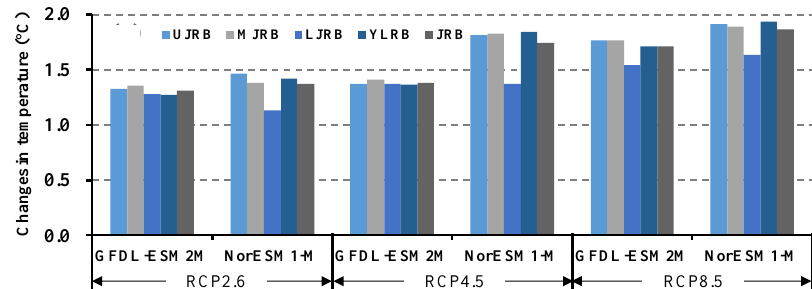
Figure 15. Changes in temperature for 2021 to 2050 in different regions.